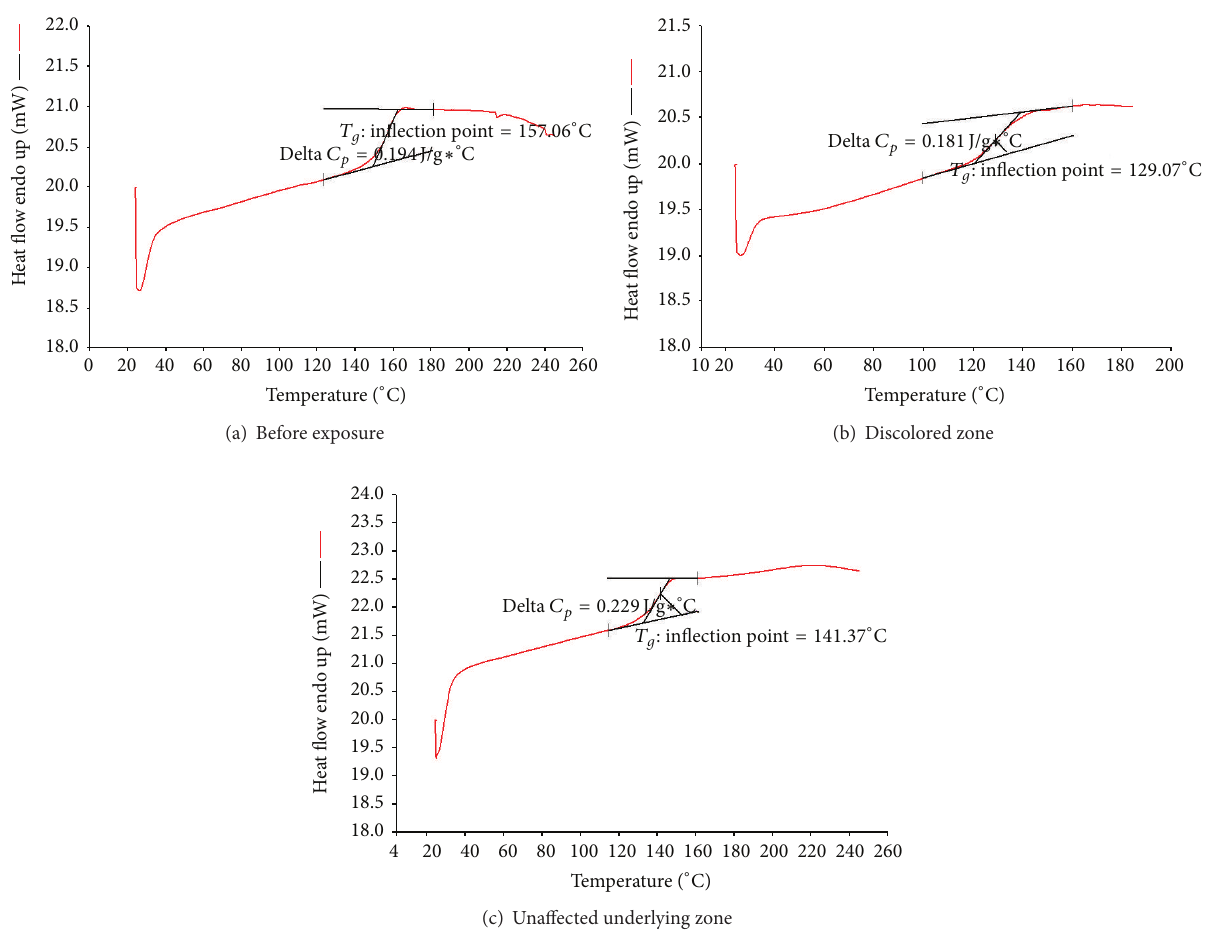
Figure 9: DSC scans of FBE coating system: (a) before exposure and after exposure to 5% NaOH solution for 30 days at 93 ∘ C/200 ∘ F (b) discolored zone, and (c) unaffected underlying zone.